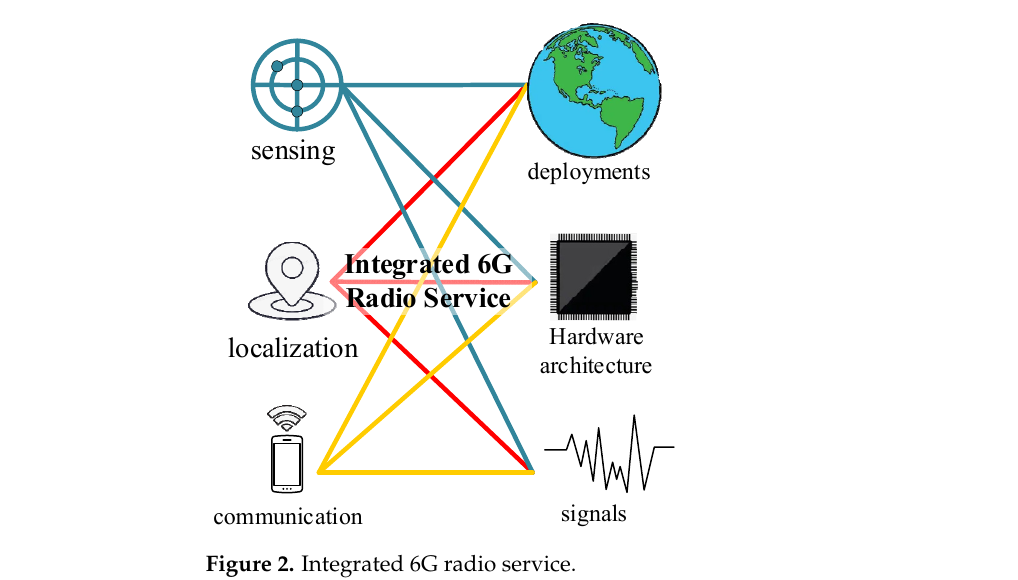
Figure 2. Integrated 6G radio service.